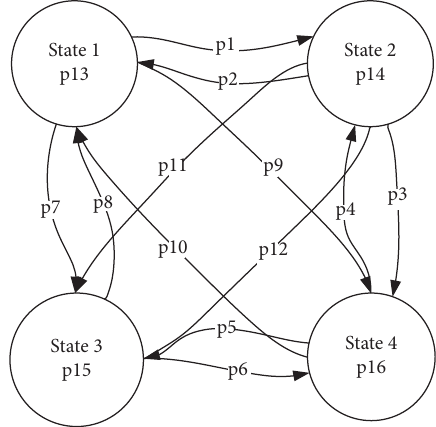
Figure 3: Markov model of language development states.